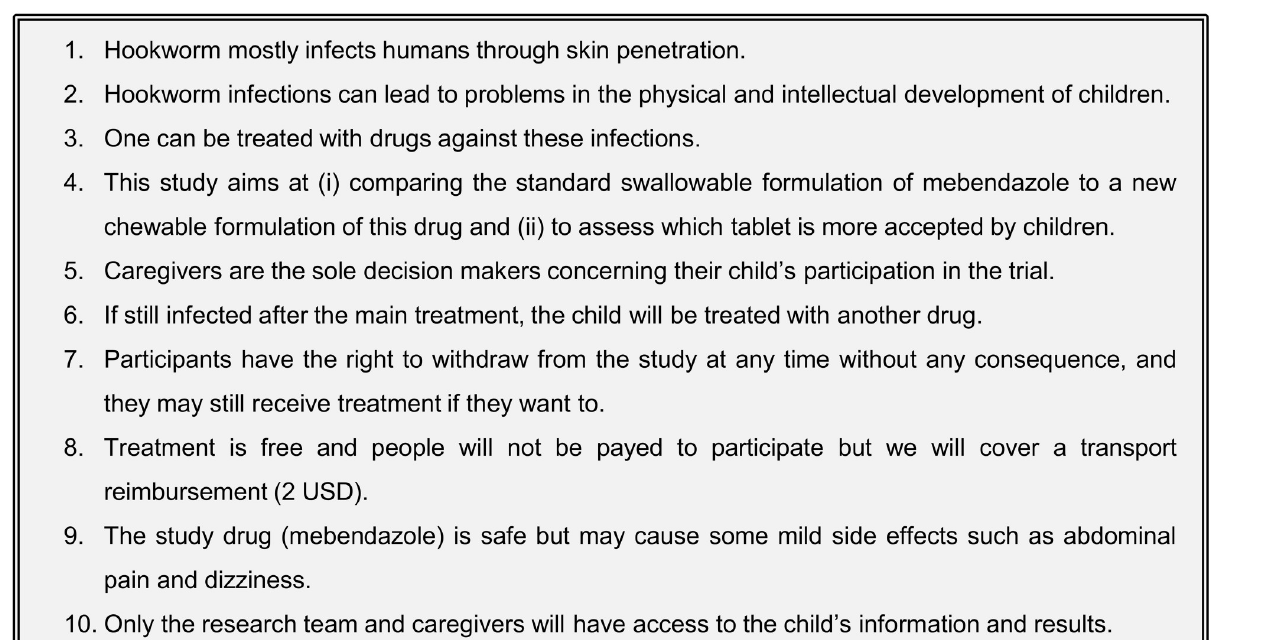
Fig 2. Key messages conveyed during all three types of